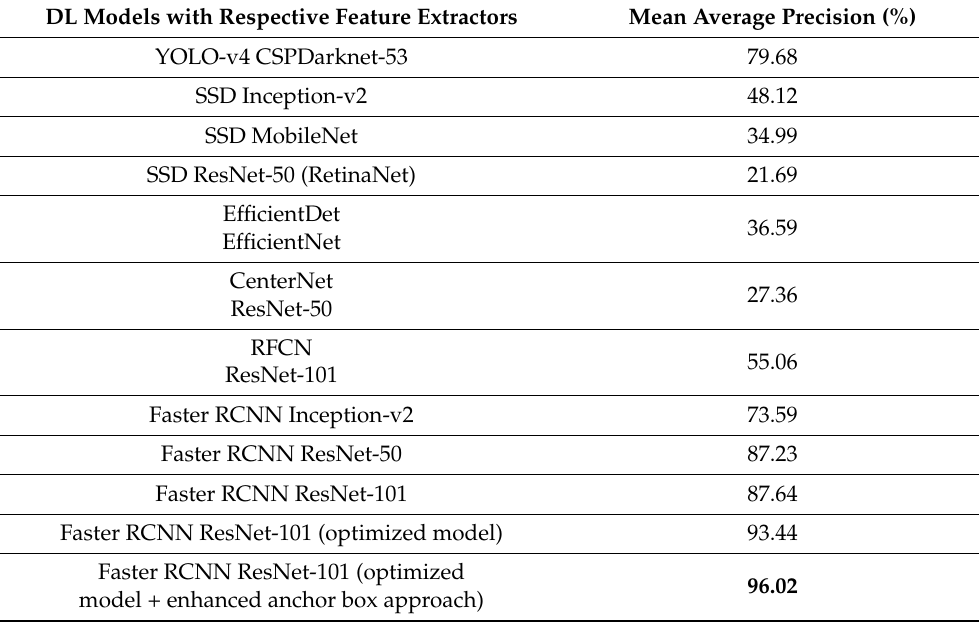
Figure 15. True-positive results with aspect ratios 1:3 and 3:1. Table 2. Performance of the proposed method compared to different DL